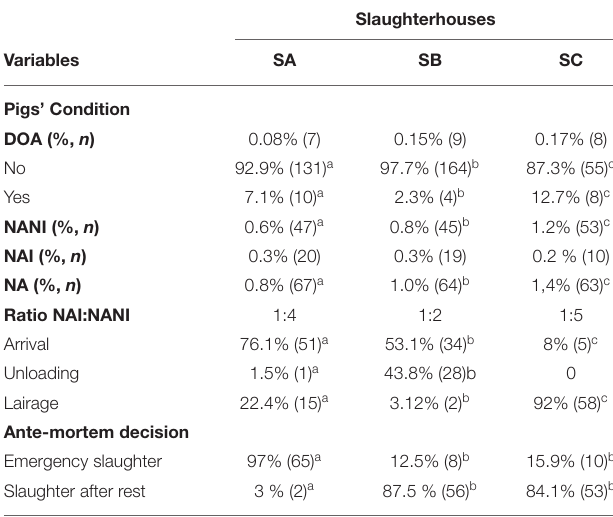
TABLE 3 | Proportions of dead-on-arrival (DOA) and non-ambulatory pigs (NA) during transport to three Colombian slaughterhouses.